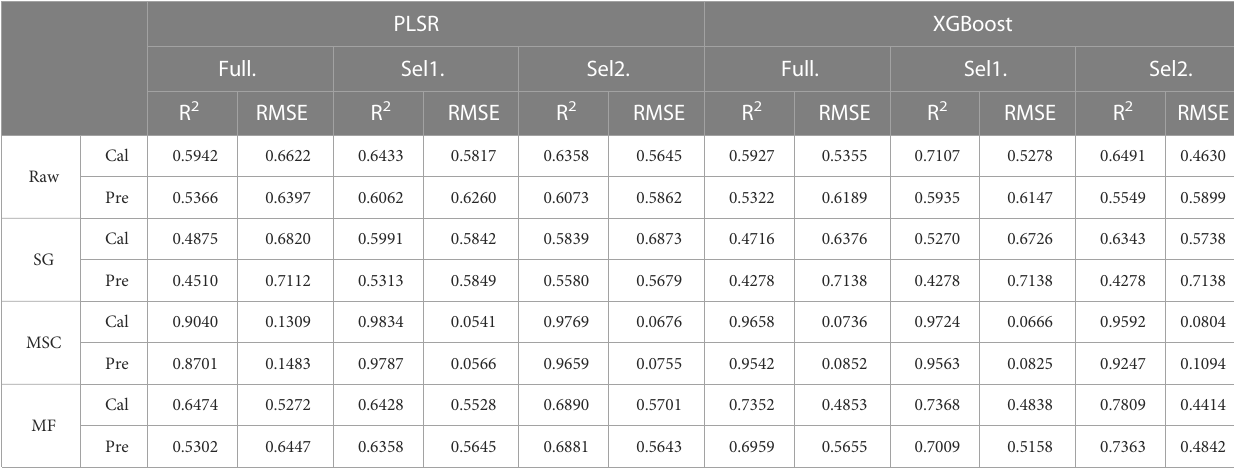
TABLE 3 SOD activity prediction result